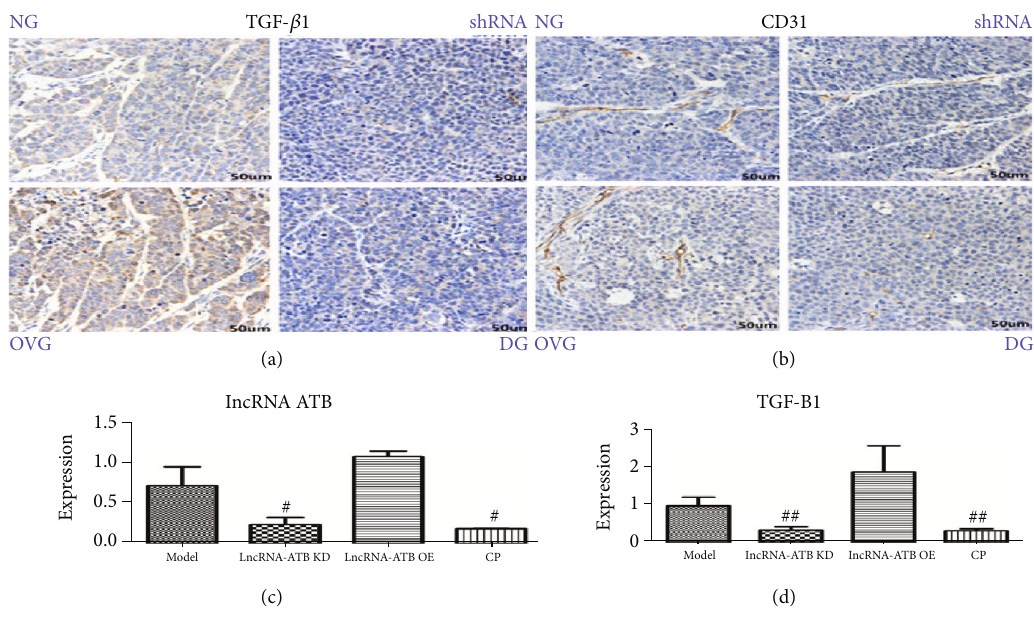
Figure 9: Immunohistochemical results: observed under the microscope, the positive was brown or yellowish brown. lncRNA-ATB promotes the growth of cervical cancer in vivo and the inhibitory e ff ect of CP on lncRNA-ATB (c), TGF- β 1 (a, d), and CD31